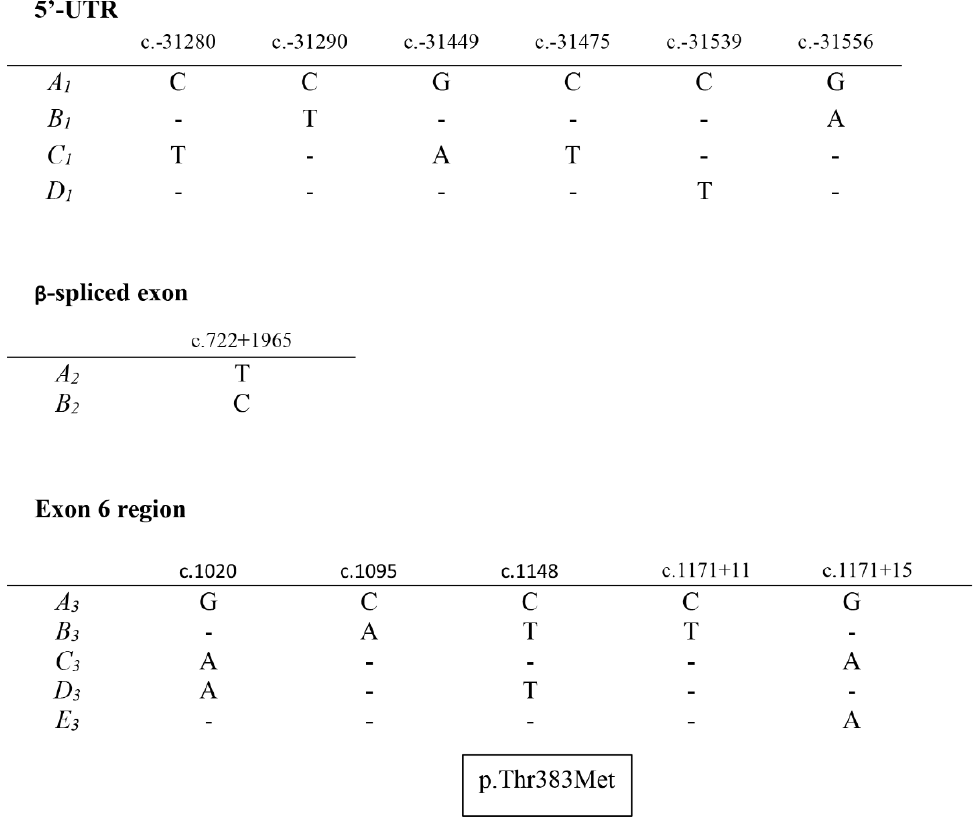
Figure 2. Variant sequences identified in three regions of ovine LPIN1 . Only the nucleotide differences are shown, and dashes represent nucleotide sequences identical to the top sequence. The numbering of nucleotides follows the Human Genome Variation Society (HGVS) recommended nomenclature (http://varnomen.hgvs.org/). The non-synonymous substitution in coding exon 6 is indicated along with the putative amino acid change.